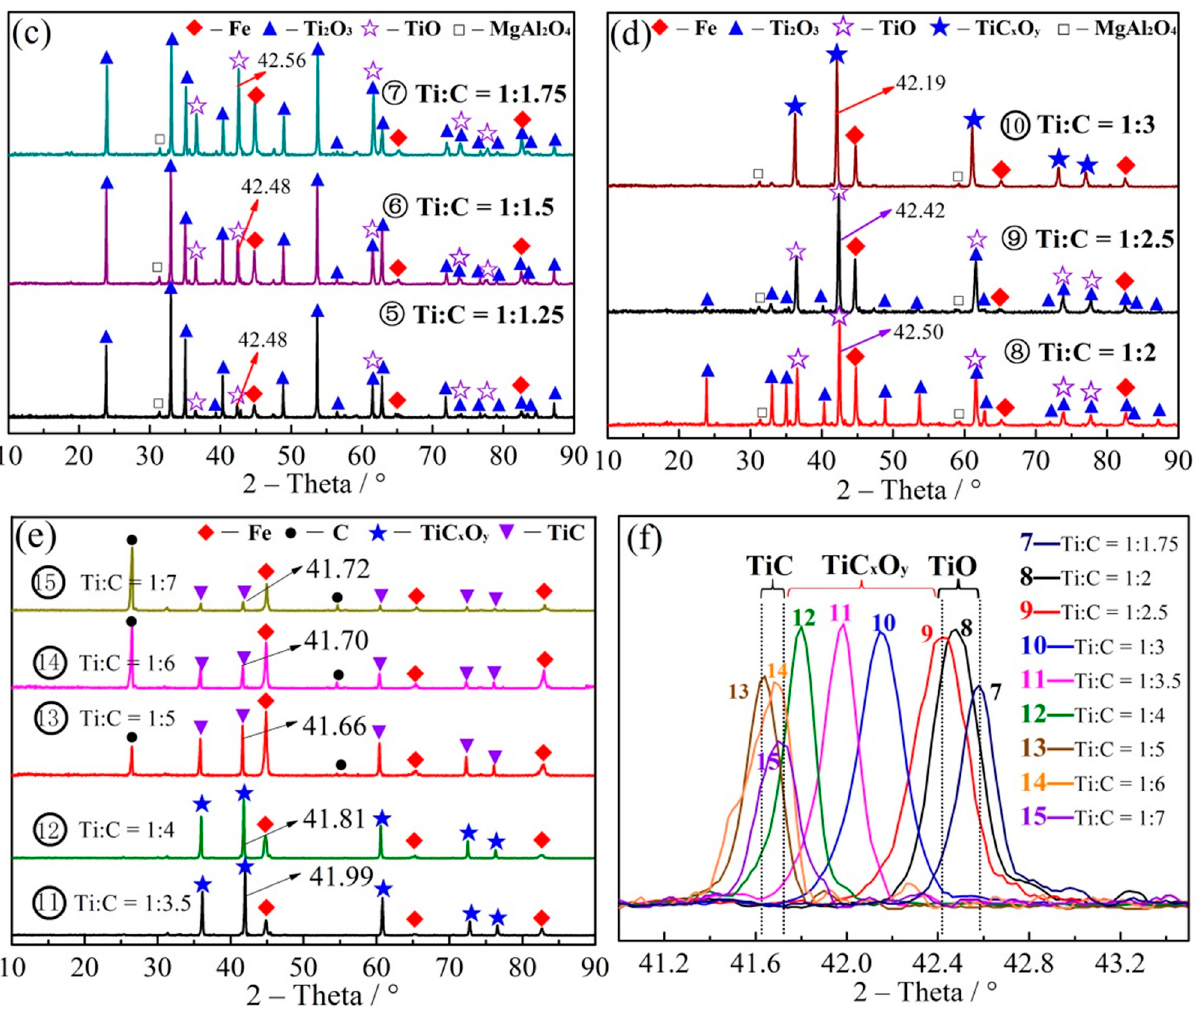
Figure 3. XRD patterns of the reduction products of ( a ) 1–2, ( b ) 3–4, ( c ) 5–7, and ( d ) 8–10, ( e ) 11–15; ( f ) XRD patterns with partial amplifications for the reduction products (7–15).